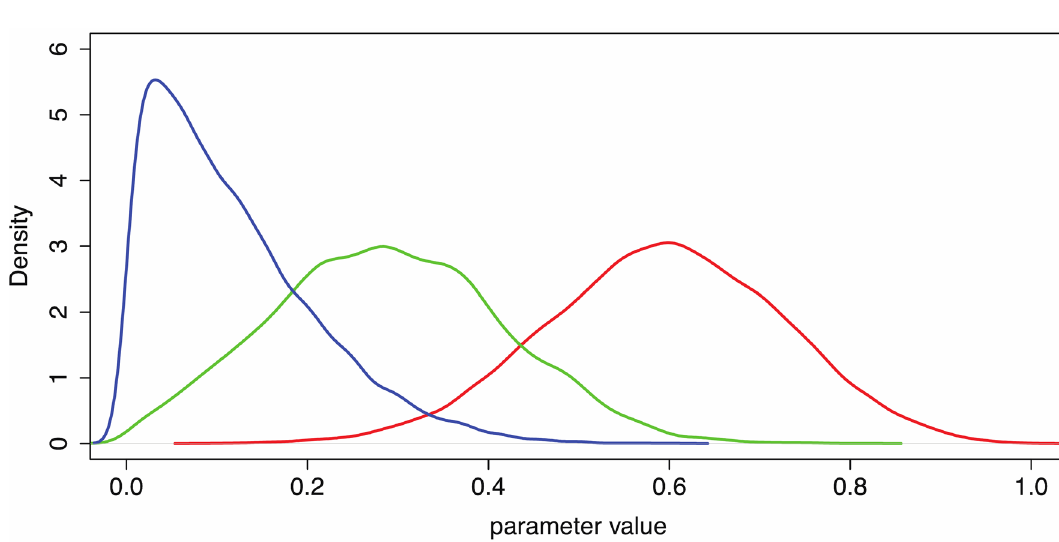
Figure 5. Posterior distributions of the parameters of model (Eqs. 6–8). Red: β 1 (VictimLookAt), Green: β 2 (PerpLookAt), Blue: β 3